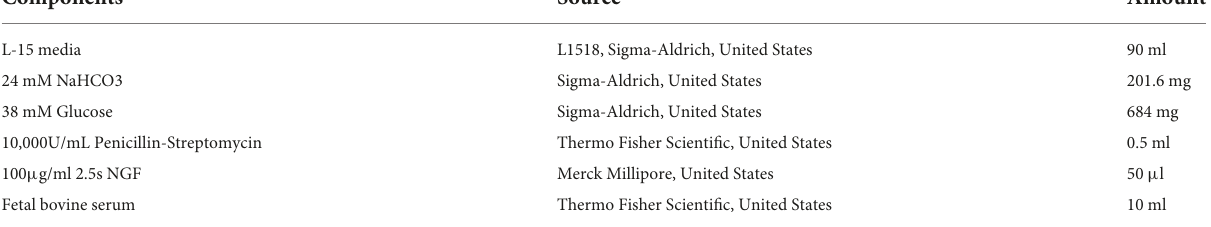
TABLE 1 L-15 based plating media. pH adjusted to 7.6 with HCl.